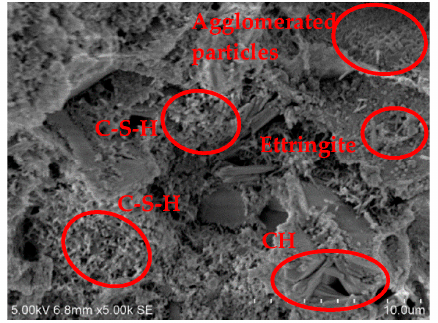
Figure 7. SEM image at 5000× of B36R4 specimen.